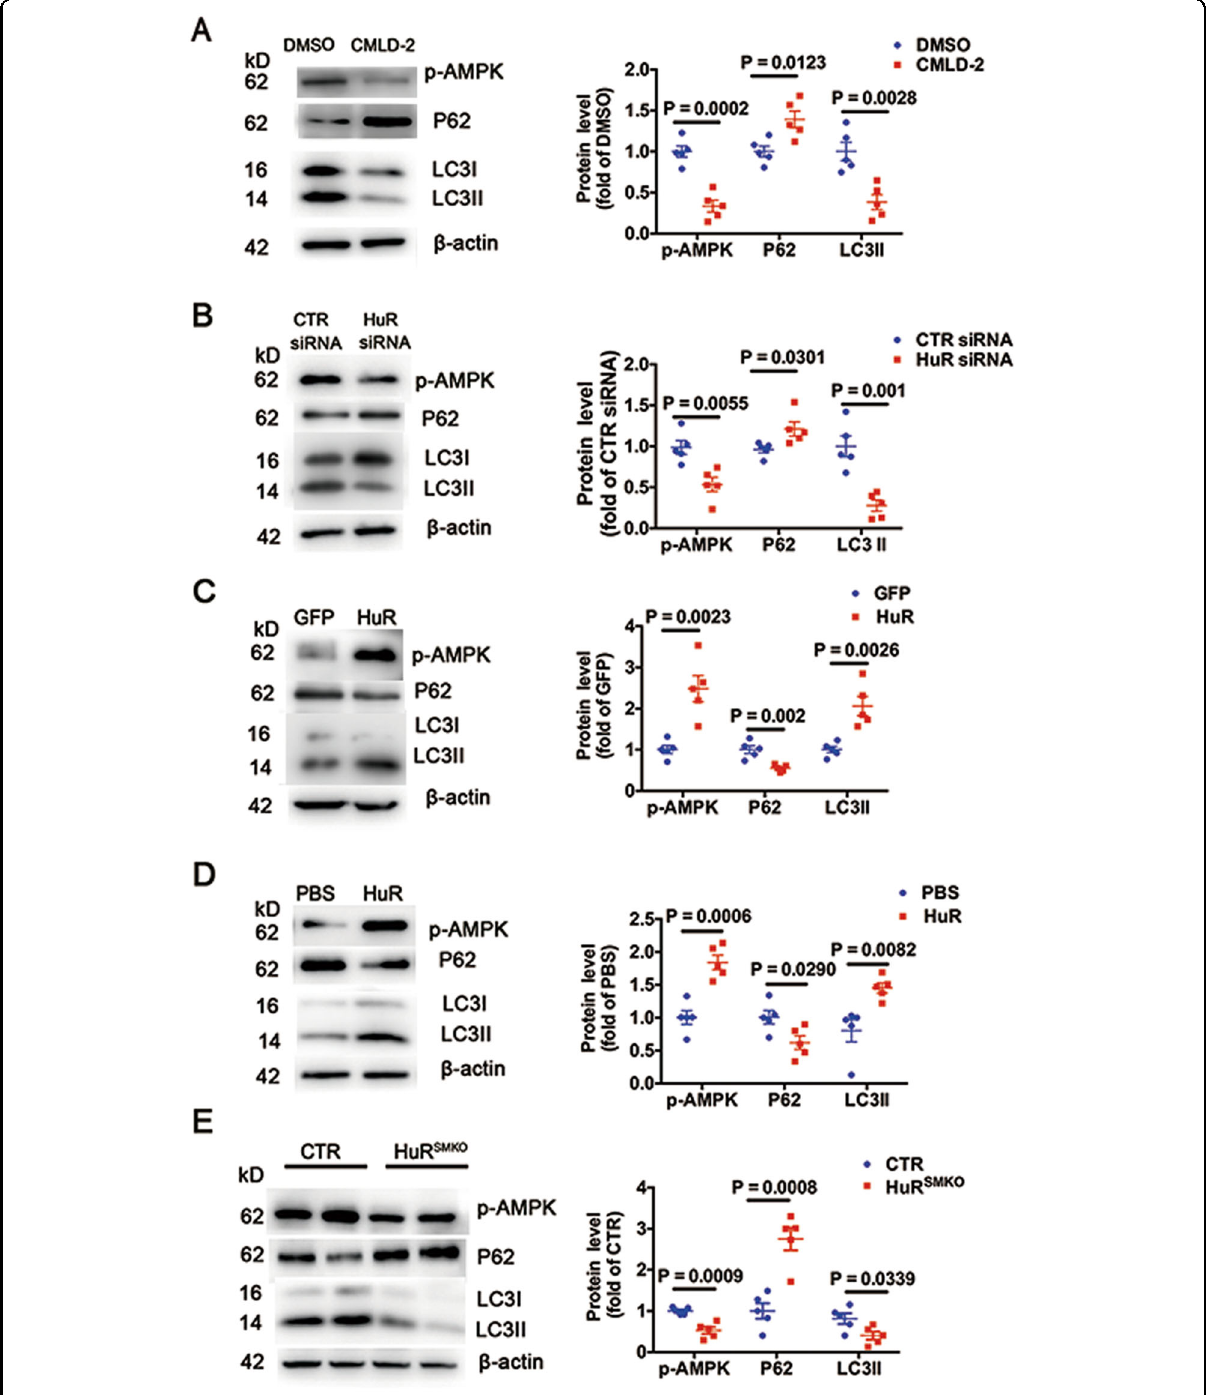
Fig. 6 HuR positively regulates autophagy. Western blot analysis of p-AMPK, p62, and LC3II in VSMCs. A Treated with DMSO or 30 μ M CMLD-2 for 24 h ( n = 5). B Transfected with CTR or HuR siRNA for 48 h ( n = 5). C Infected with ad-GFP or ad-HuR ( n = 5), and D treated with PBS or 0.5 μ g/ μ l recombinant HuR protein for 48 h ( n = 5). E Western blot analysis of p-AMPK, p62, and LC3II in aortas from CTR and HuR SMKO mice ( n =